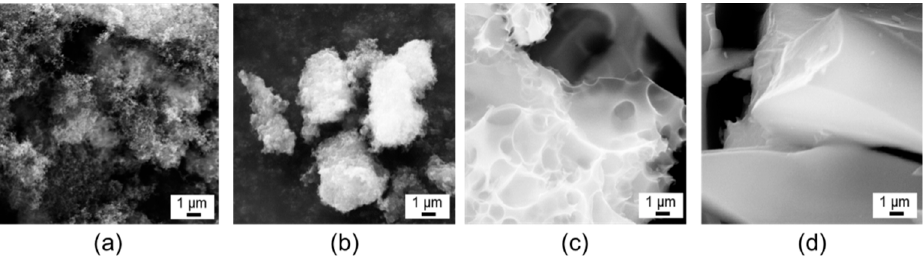
Figure 1. SEM images of ( a ) ox-V; ( b ) ox-BP; ( c ) aPRS KOH ; and ( d ) aRS H3PO4 . Nitrogen sorption experiments were carried out to investigate the porosity. The isotherms are shown in Figure 2a and can be classified according to IUPAC as follows: Type II for ox-V, type IVa for ox-BP, type Ia for aPRS KOH , and type IVa for aRS H3PO4 [45]. The type-II-isotherm is typical for less porous and furthermore macroporous carbons like Vulcan ® which is in agreement with the comparable low surface area of 179 m 2 /g and low pore volume of 0.2 cm 3 /g also shown in Figure 2b. The type-I-isotherm identifies microporous materials with a small external surface area and high micropore surface area [45]. This is the case for the KOH-activated biochar, which further shows a high specific surface area of 2015 m 2 /g and high micropore volume (Figure 2b). The type-IVa- isotherm is observed for mesoporous materials with pores larger than 4 nm and typically includes a hysteresis caused by pore condensation [45]. This is the case for aRS H3PO4 and ox-BP, whereby the latter material exhibits a hysteresis type H3, indicating the presence of macropores according to IUPAC [45]. For the aRS H3PO4 the hysteresis of the isotherm in Figure 2a already starts at low relative pressures of 0.4, indicating hysteresis type H4 and smaller mesopores compared to the ox-BP. Both materials show a comparable low micropore and high mesopore volume of 0.95 cm 3 /g in case of aRS H3PO4 and 0.80 cm 3 /g in case of ox-BP besides a moderate surface area higher than 800 m 2 /g in Figure 2b. Summarizing the N 2 sorption results, three materials show a moderate surface area and porosity namely, ox-BP, aPRS KOH , and aRS H3PO4 , whereas the ox-V has a low surface area and low pore